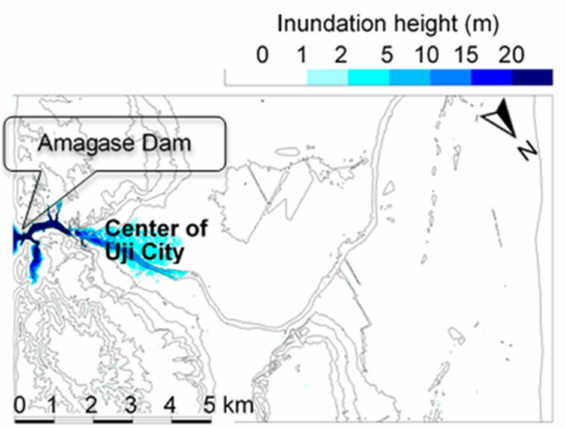
Figure 29. (Case–4). Inundation height, 10 min after start of the calculation.